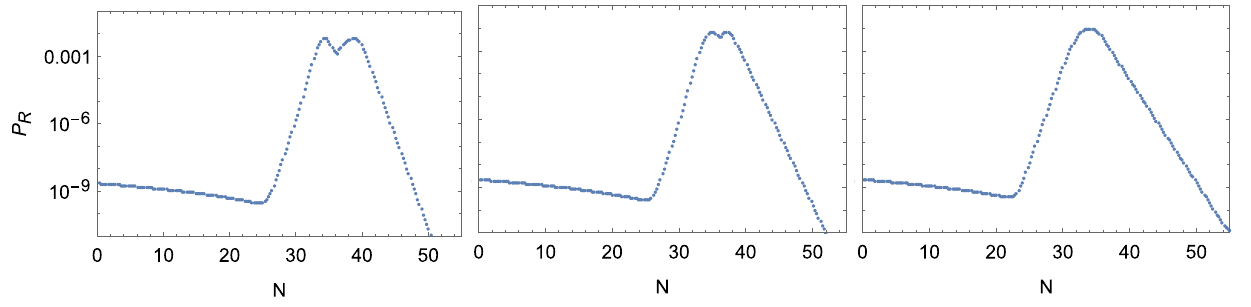
Fig. 11 The power spectra P R for three parameter sets in Table 5: b = 0 . 01 (on the left), b = 0 . 1 (in the center), and b = 1 (on the right)